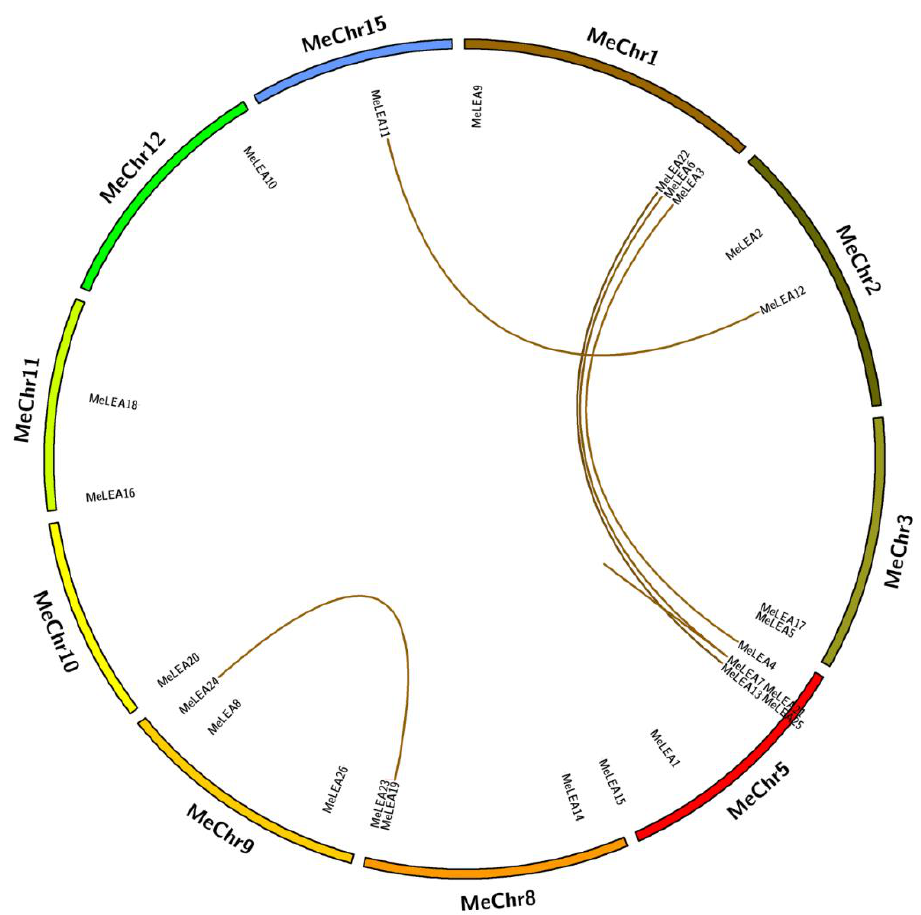
Figure 5. Segmental duplication of LEA genes in cassava. Chromosomes are illustrated in different colour in circular form using the program Circos. Segmental duplicated MeLEAs are connected by yellow lines.